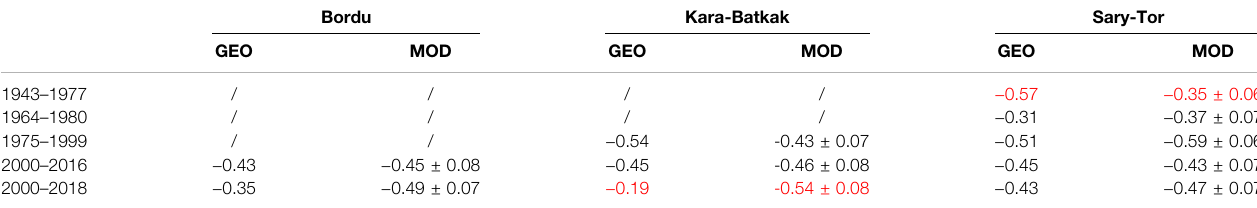
TABLE9| Comparisonbetweenmodelledandgeodeticandmodelled(revert)massbalances(GEO (cid:1) observedgeodeticmassbalance,MOD (cid:1) theaveragemodelledmean speci fi c mass balance of the overlapping period). All values are in m w.e. yr − 1 . Comparisons with a difference larger than 0.2 m w.e. yr − 1 are indicated in red. (Data